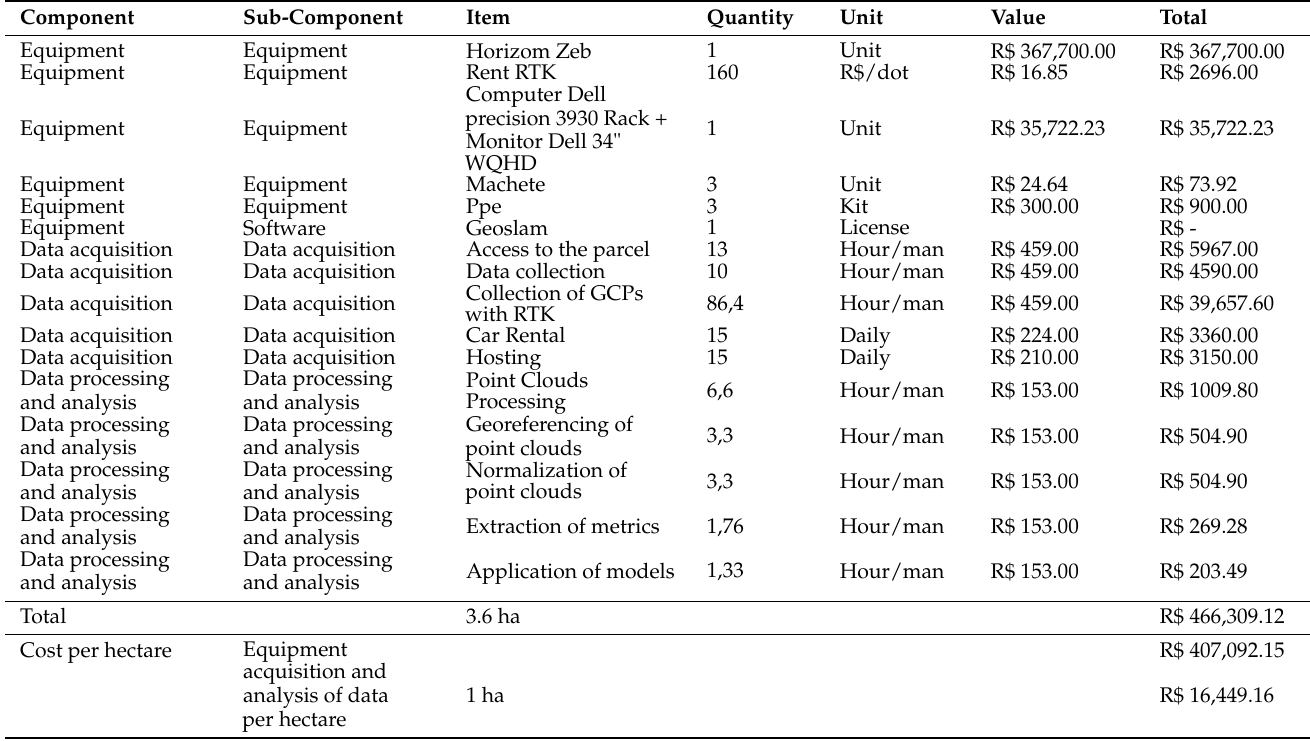
Table A2. Inventory cost components with terrestrial LiDAR.